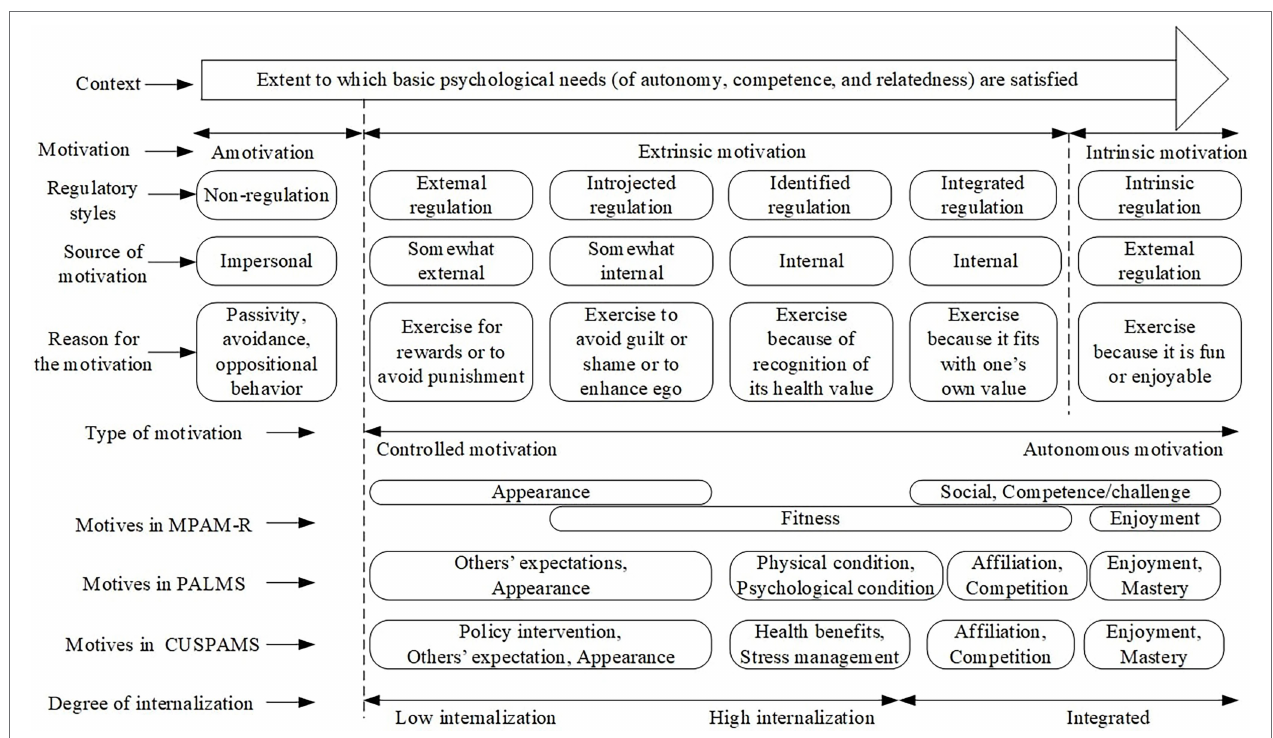
FIGURE 1 | Theoretical framework of Chinese University Students’ Physical Activity Motivation Scale (CUSPAMS). Source: adapted from self-determination theory (Ryan and Deci,